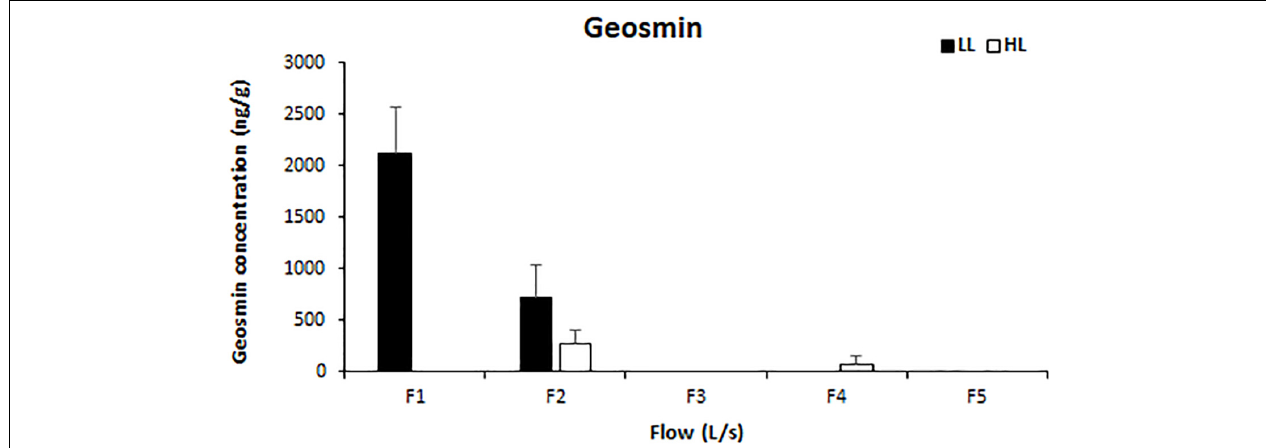
FIGURE 6 | Mean values and standard deviation for intracellular geosmin concentration (ng/g) in biofilm of each treatment, from the lowest flow (F1) to the highest (F5), under conditions of natural light (HL) and reduced (LL), at the end of the experiment ( t = 41